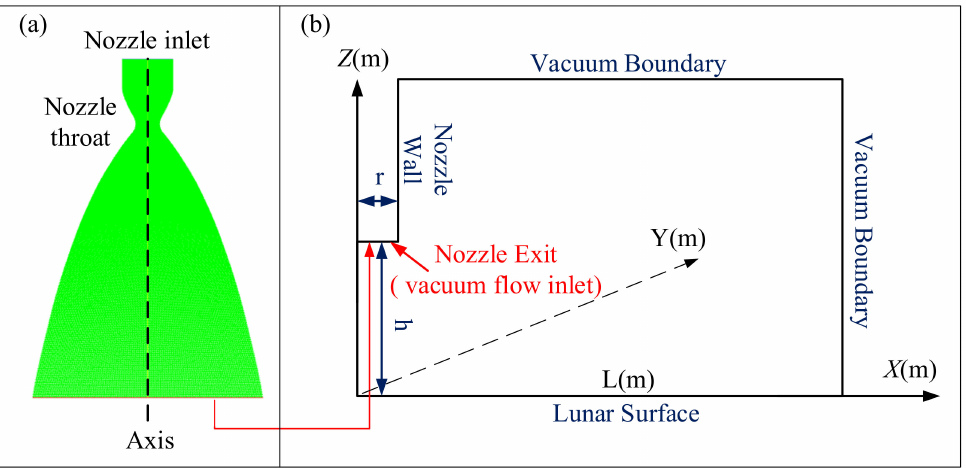
Figure 2. Plume flow simulation model: ( a ) Chang’E-5 nozzle geometry and ( b ) lunar vacuum flow simulation